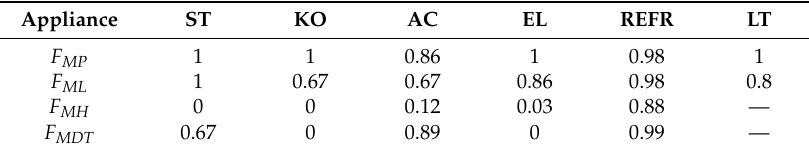
Table 4. Performance of four low-rate NILM algorithms for House 6.